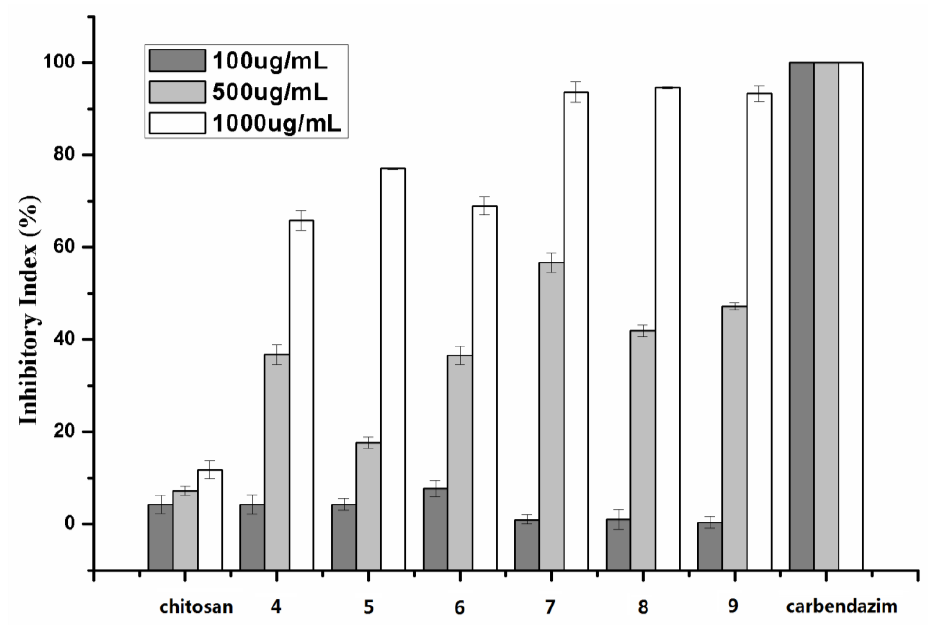
Figure 3. The antifungal activity of chitosan and chitosan derivatives against Fusarium